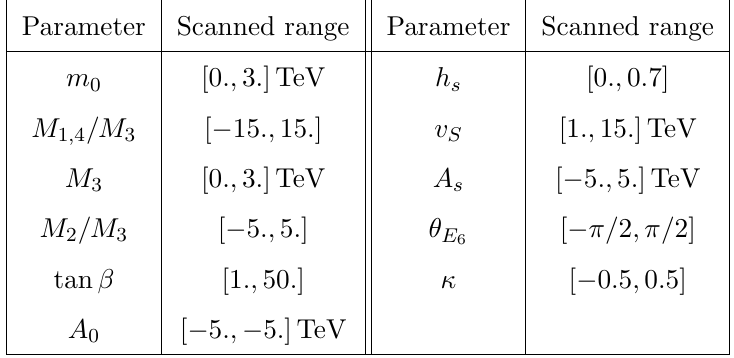
Table 2 . Scanned parameter